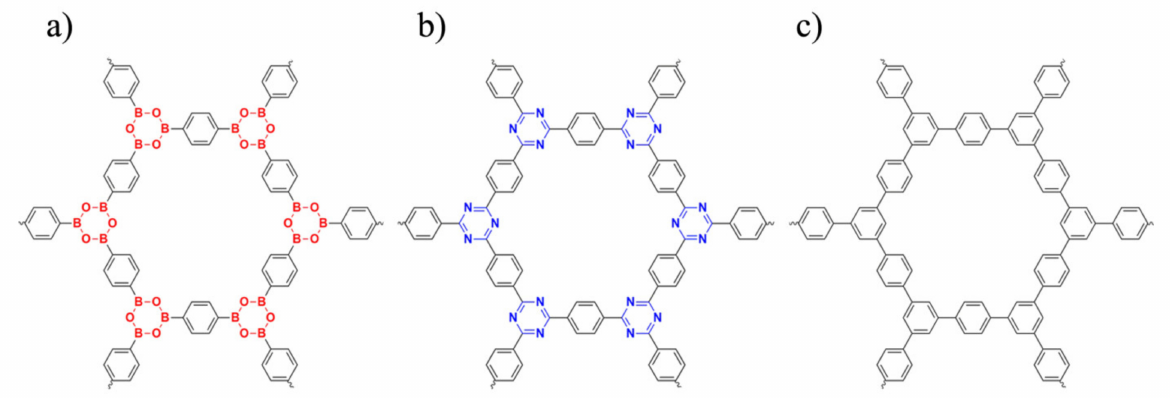
Figure 1. Two-dimensional molecular structure of ( a ) COF-1, ( b ) CTF-1 and ( c ) TPG that were studied in this